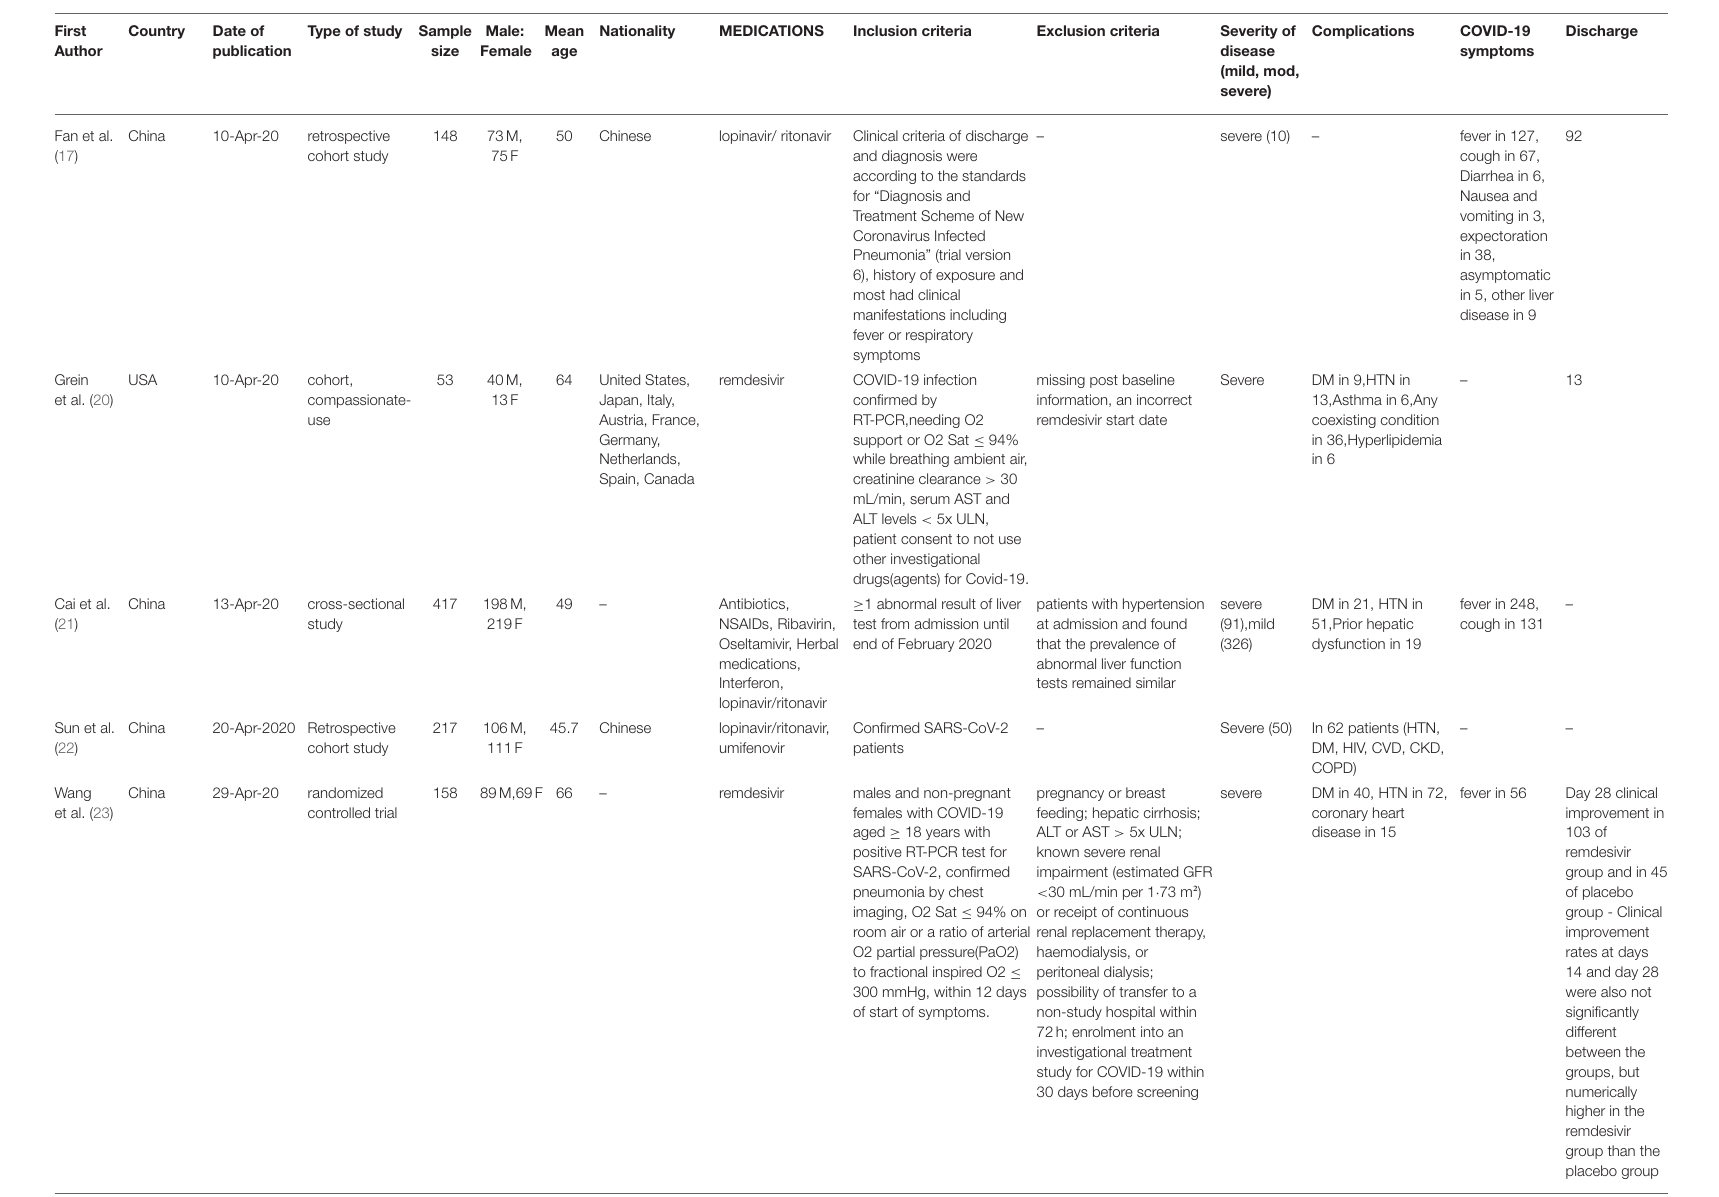
TABLE 1 | Characteristics of included